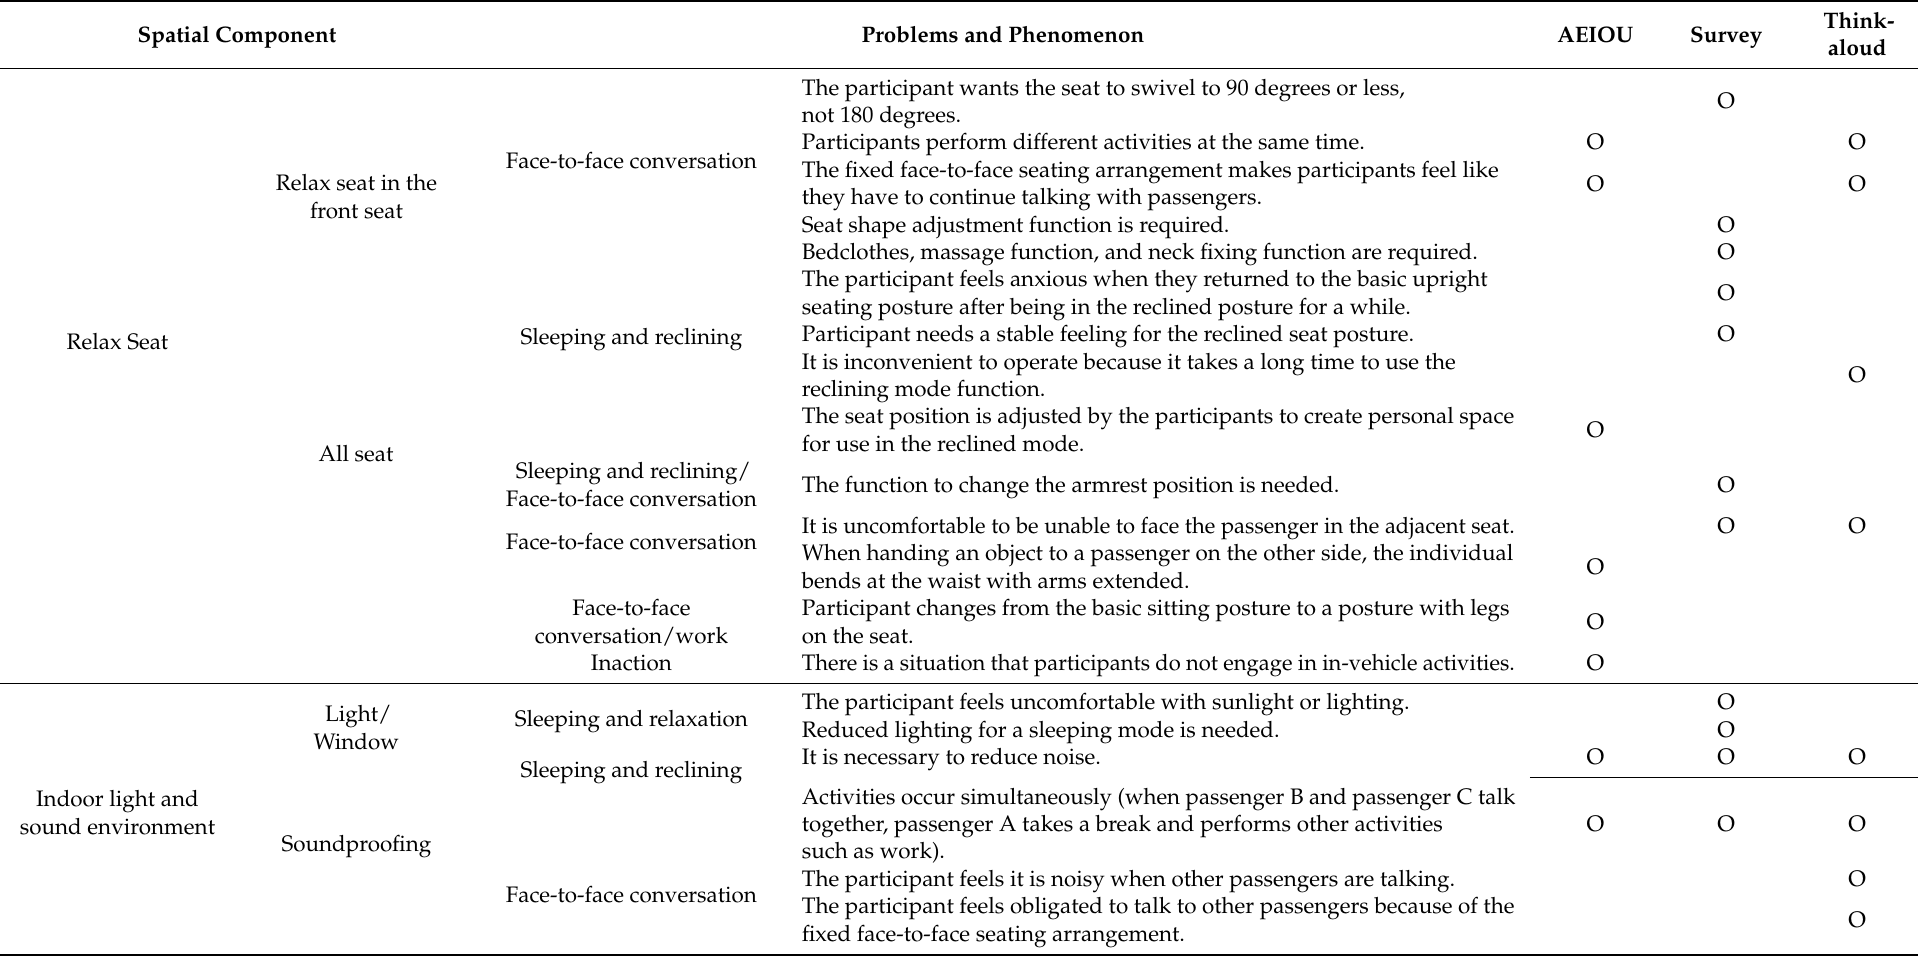
Table 9. Design considerations for each spatial